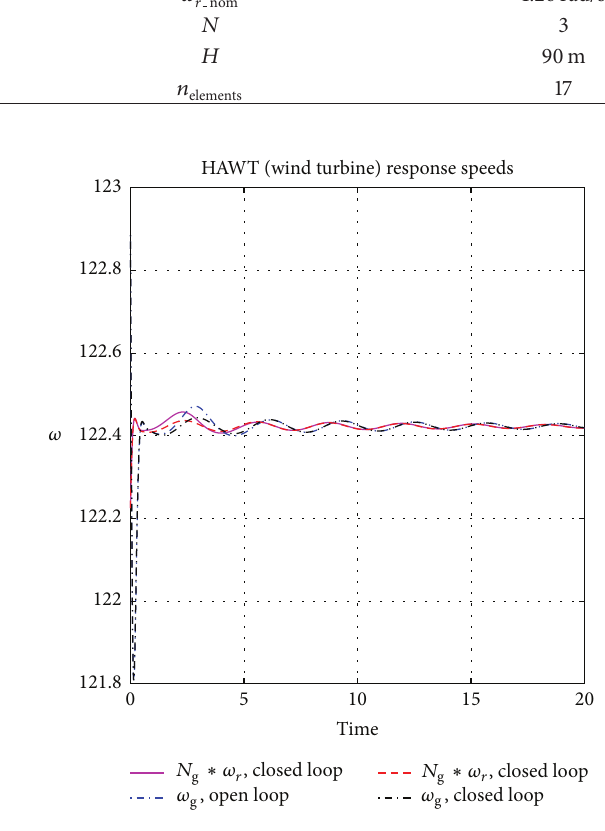
Figure 2: Horizontal axis wind turbine (HAWT) open and closed loop response